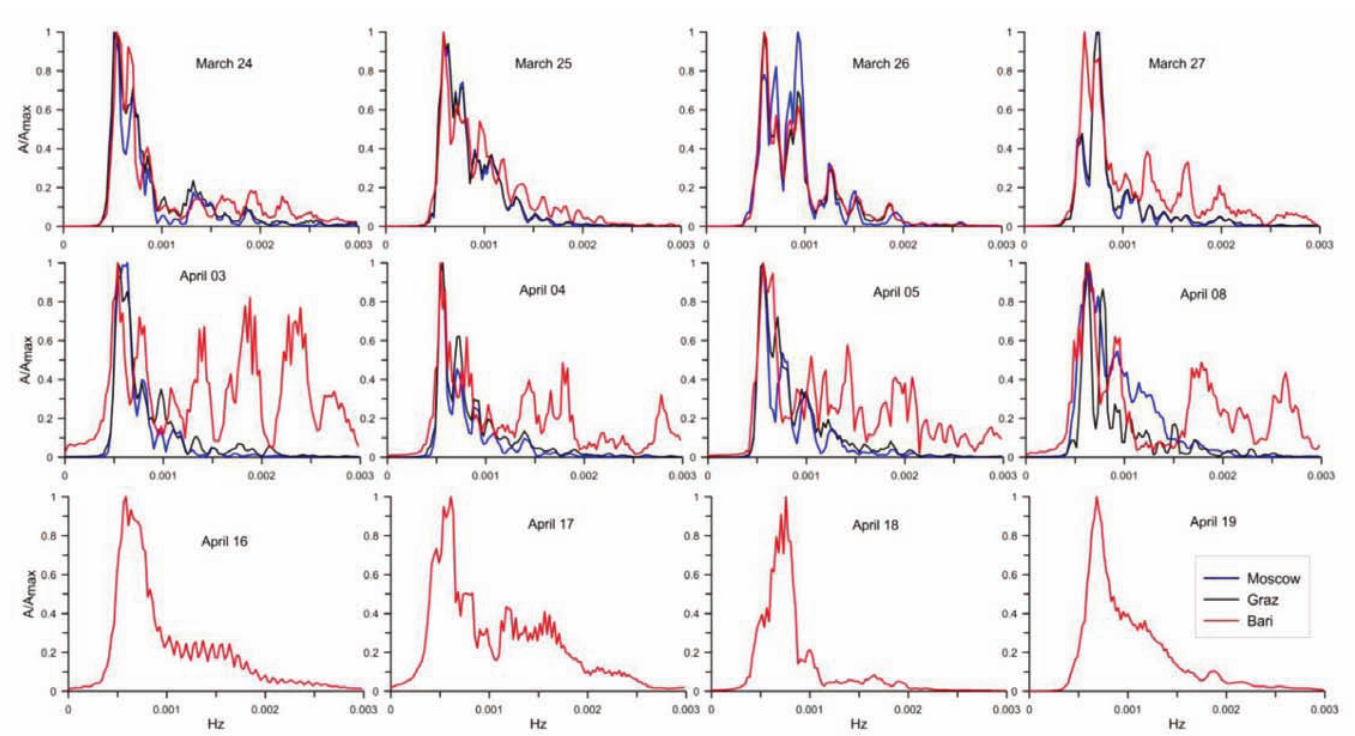
Figure 3. Normalized spectra of the filtered (0.28-15 mHz) amplitudes of the NRK signals. Upper panels: Spectra for Bari, Graz and Moscow for quiet days at the end of March, 2009, well before the occurrence of the earthquakes. Middle panels: Spectra for Bari, Graz and Moscow for days when the seismo-induced anomalies were observed in the NRK-Bari propagation path. Bottom panels: Spectra for Bari for the quiet days after the earthquake.